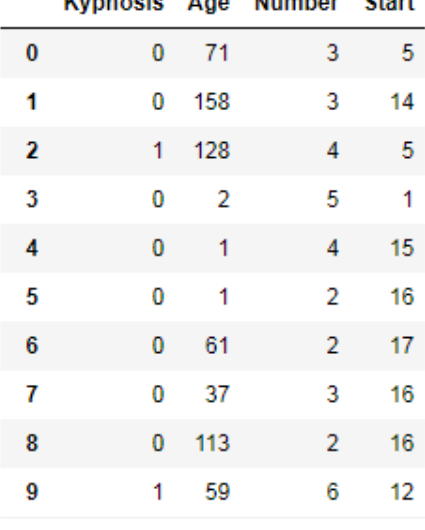
Figure 3. A screenshot of the kyphosis data (first top 10 records) after the kyphosis class column has been transformed in to 0′ s and 1′ s.